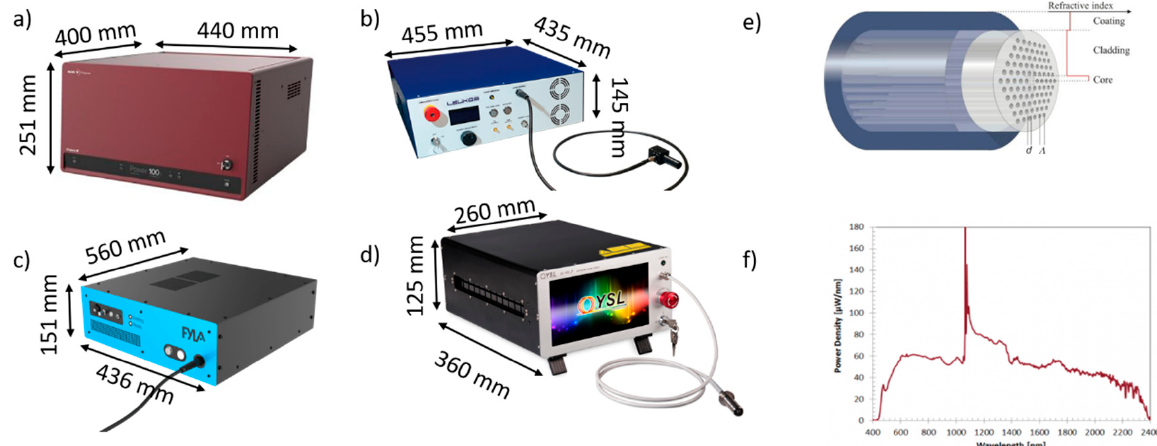
Figure 1. Example of commercial SC laser sources and their typical spectra. ( a ) Fianium source, ( b ) Leukos source, ( c ) FYLA source, ( d ) YSL source. ( e ) Schematic of the classical triangular cladding single-core photonic crystal fiber in which light is guided in a solid core embedded in a triangular lattice of air holes. The fiber structure is determined by the hole-size, d, and the hole-pitch, Λ . Like standard fibers, the PCF is coated with a high index polymer for protection and to strip off cladding-modes. Extracted from the application note on supercontinuum generation in photonic crystal fibers by NKT. ( f ) Example of full spectrum generated by a SC laser, showing the width of the broadband emission and the central peak wavelength that is a residual of the single-mode laser used for SC generation. The spectrum is taken from the SuperK COMPACT SC laser manufactured by NKT Photonics (https://www.nktphotonics.com/lasers-fibers/product/superk-com- pact-supercontinuum-lasers/, accessed date: 1 November 2021).